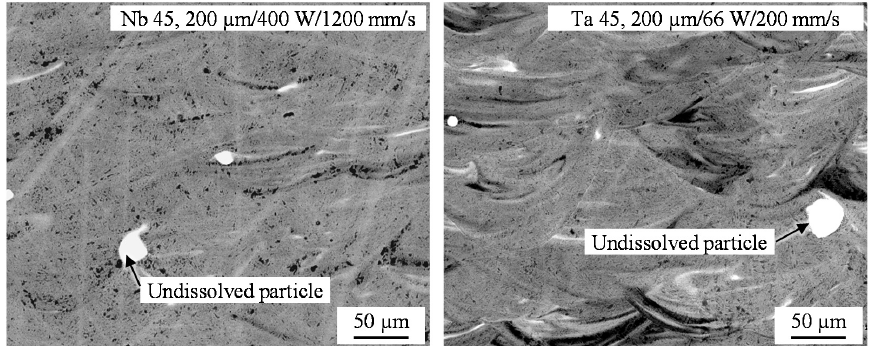
Figure 7. SEM-images of two samples from series 1 and series 2 (see Table 2) with equal volumetric energy density (VED) (55 J/mm 3 ); images recorded with equal SEM-settings (HV = 20 kV, I A = 5.5 nA, CBS; FEI Helios Nanolab 600); flow marks clearly visible in the Ta 45